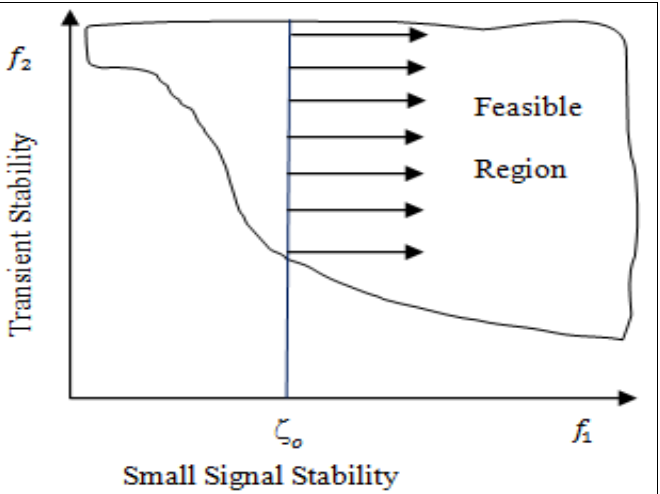
Figure 2: AVR and PSS